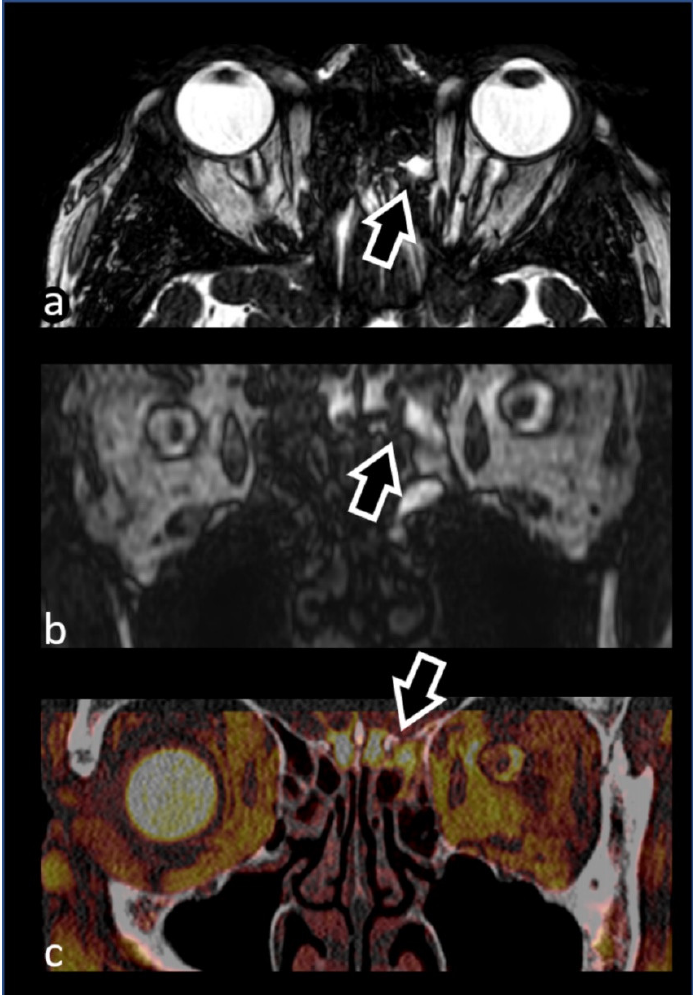
Figure 4. 74-year-old female patient presenting with watery fluid leaking from her left nostril, suspected for cerebrospinal fluid (CSF) leakage. Axial ( a ) and coronal ( b ) 3D CISS images show a CSF-like linear hyperintensity extending from a subarachnoid space in the left frontal pole into an anterior ipsilateral ethmoid cell (arrows). At that level, computed tomography (CT) performed on the same day revealed a bony defect of the cribriform plate. These findings, well represented on postprocessed fused CT and MR-cisternographic images ( c ), were in keeping with a CSF fistula. A left partial ethmoidectomy was performed the following week, revealing a focal meningocele and confirming the CSF fistula. The meningocele was repaired, with a complete resolution of symptoms at one-month follow-up.